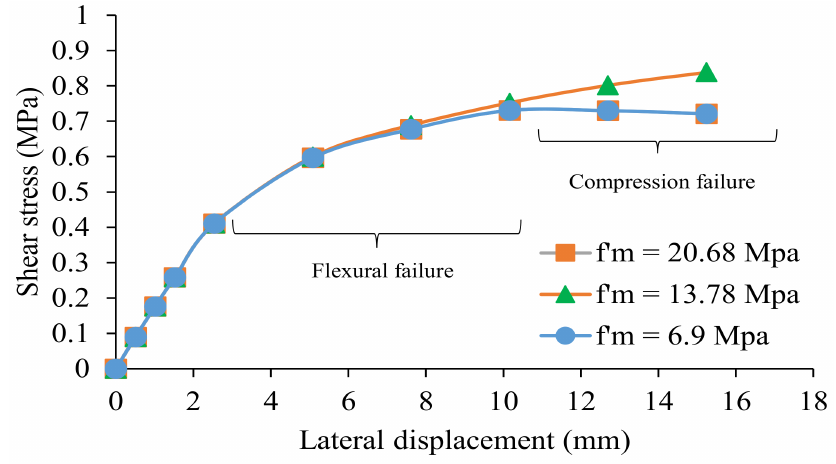
Figure 12. Influence of compressive strength on shear strength of URM walls.